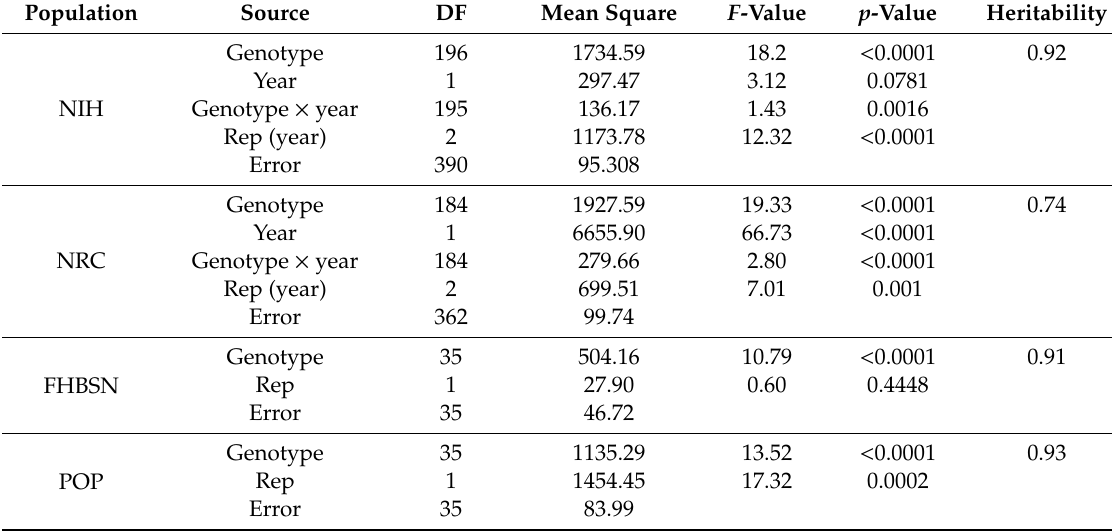
Table 2. Analysis of variance for Fusarium head blight (FHB) and its heritability estimates in “NASMA” × “IAS20*5 / H567.71” (NIH), “NASMA” × “RPB709.71 / COC” (NRC), 16th Fusarium head blight screening nursery (FHBSN), and “Panel of Parents” (POP)